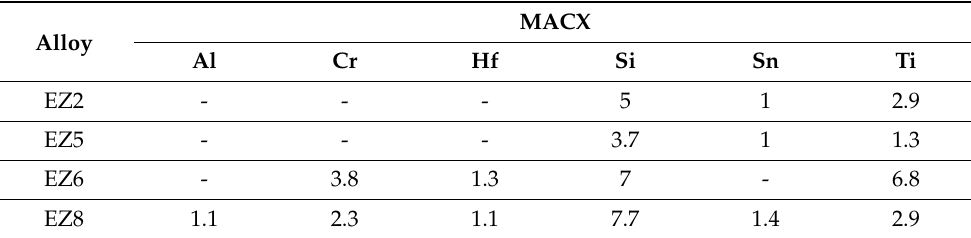
Table 2. Macrosegregation (at.%) MACX of addition X (X = Al, Cr, Hf, Si, Sn, Ti) in the AC alloys EZ2, EZ5, EZ6, and EZ8.